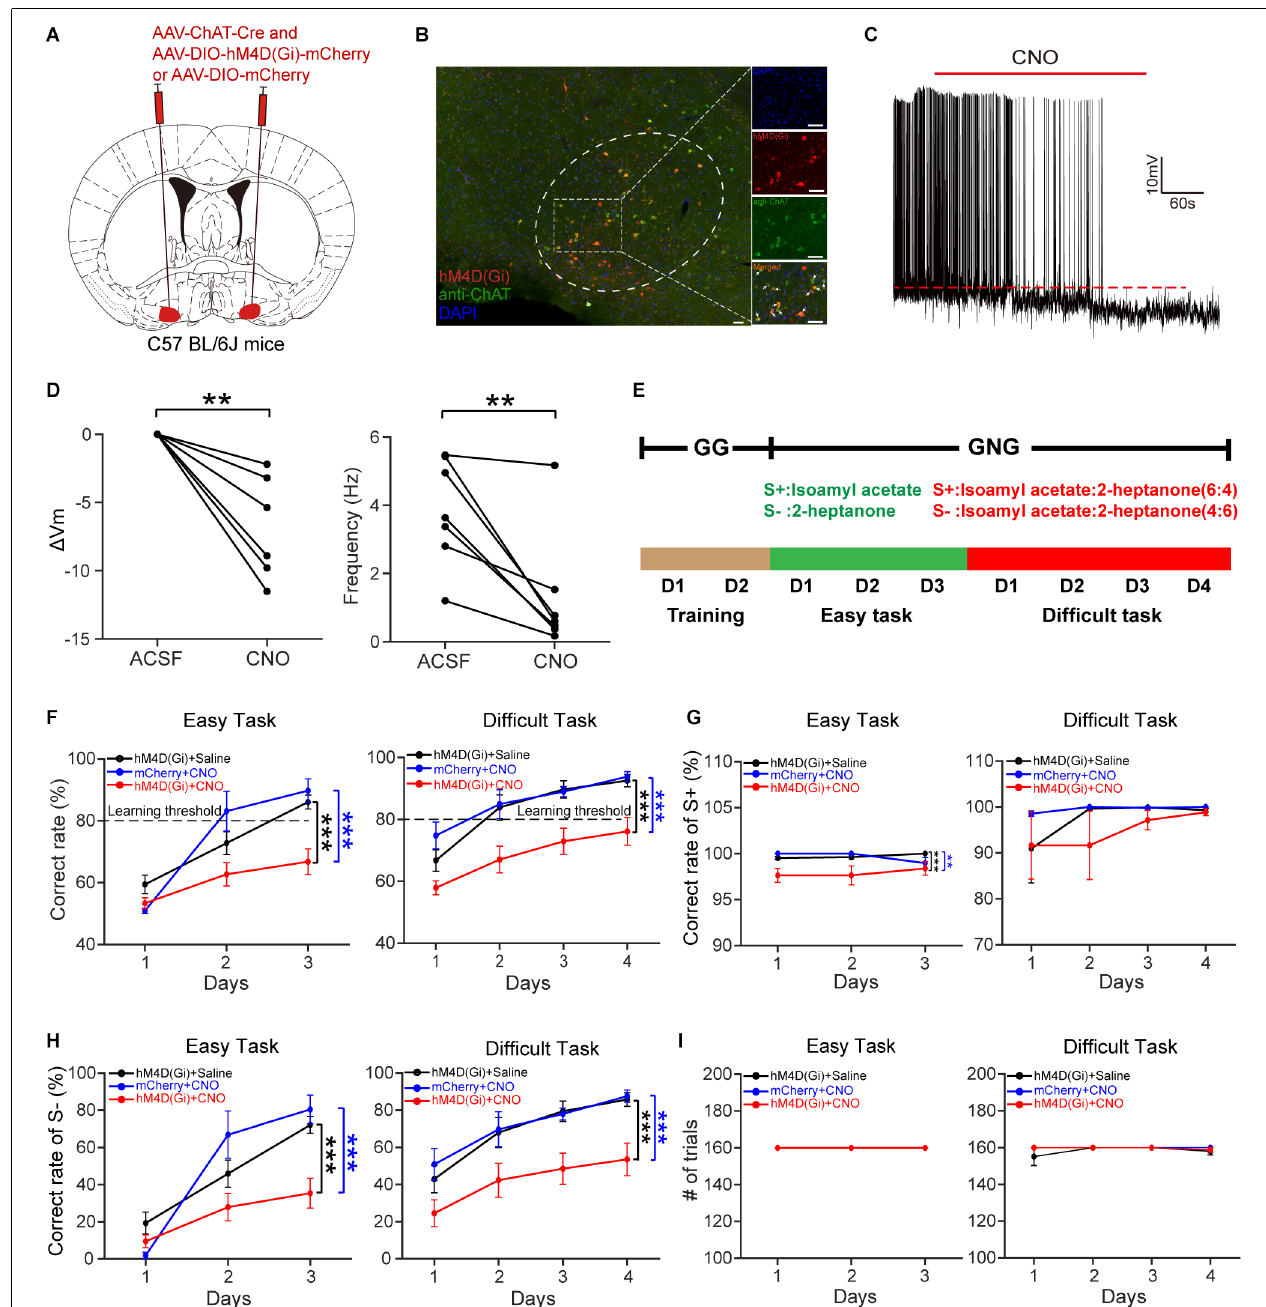
FIGURE 7 | Chemogenetic inactivation of HDB cholinergic neurons impairs odor discrimination. (A) Schematic of virus injection. AAV-ChAT-Cre and AAV-DIO-hM4D (Gi)-mCherry/AAV-DIO-mCherry were injected into bilateral HDB of C57BL/6J mice. (B) Expression of hM4D(Gi)-mCherry in HDB cholinergic neurons. The white arrows indicate merged neurons. Scale bar: 50 µ m. (C) A representative trace recorded from a current-clamped neuron expressing hM4D(Gi). (D) Comparison of the change in membrane potential ( ∆ Vm) and frequency of action potentials before and after the application of CNO (Left: paired t -test, t (6) = 5.32, P = 0.0018; Right: paired t -test, t (6) = 3.93, P = 0.0077; n = 7 cells from four mice). (E) Schematic of the olfactory discrimination task. (F) Comparison of odor discrimination performance between control (black, n = 13 mice; blue, n = 6 mice) and experimental (red, n = 13 mice) mice during the easy task (left) and the difficult task (right) (Left: two-way ANOVA, F (2,91) = 12.3, P = 1.88 × 10 − 5 ; Right: F (2,122) = 25.9, P = 4.16 × 10 − 10 ). (G) Comparison of correct rates in S+ trials between control and experimental mice during the easy task and the difficult task (two-way ANOVA, Easy task: F (2,91) = 9.39, P = 2 × 10 − 4 , Difficult task: F (2,122) = 0.93, P = 0.40). (H) Comparison of correct rates in S– trials between the three groups of mice (two-way ANOVA, Easy task: F (2,91) = 10.68, P = 6.84 × 10 − 5 ; Difficult task: F (2,122) = 18.94, P = 6.9 × 10 − 8 ). (I) Comparison of the number of trials completed by the animals in the three groups during the go/no-go task (two-way ANOVA, Difficult task: F (2,122) = 0.93, P = 0.40). ** P < 0.01, *** P <